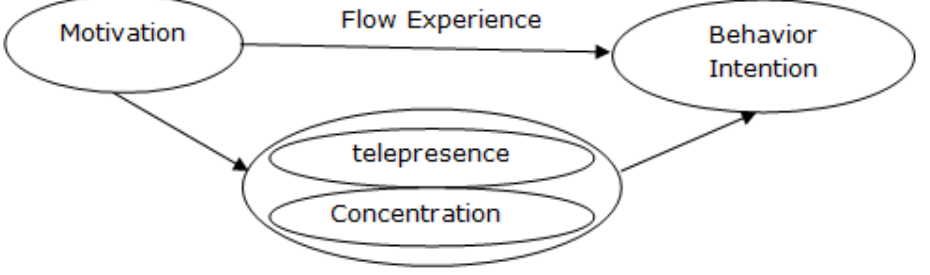
Figure 1. The Proposed Research Model of Flow Experience in China Tourism